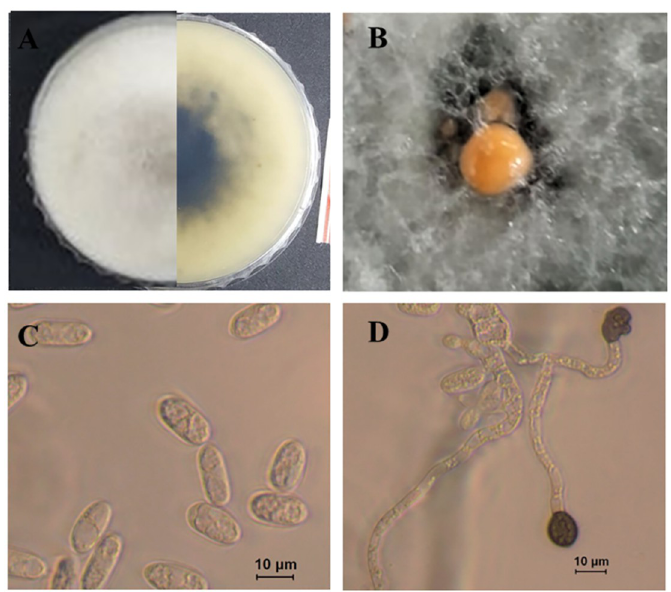
Fig 8. Morphological characteristics of C . cigarro (isolate SPL93). A: Colony on PDA above and below. B: Conidioma. C: Conidia. D: Appressoria.